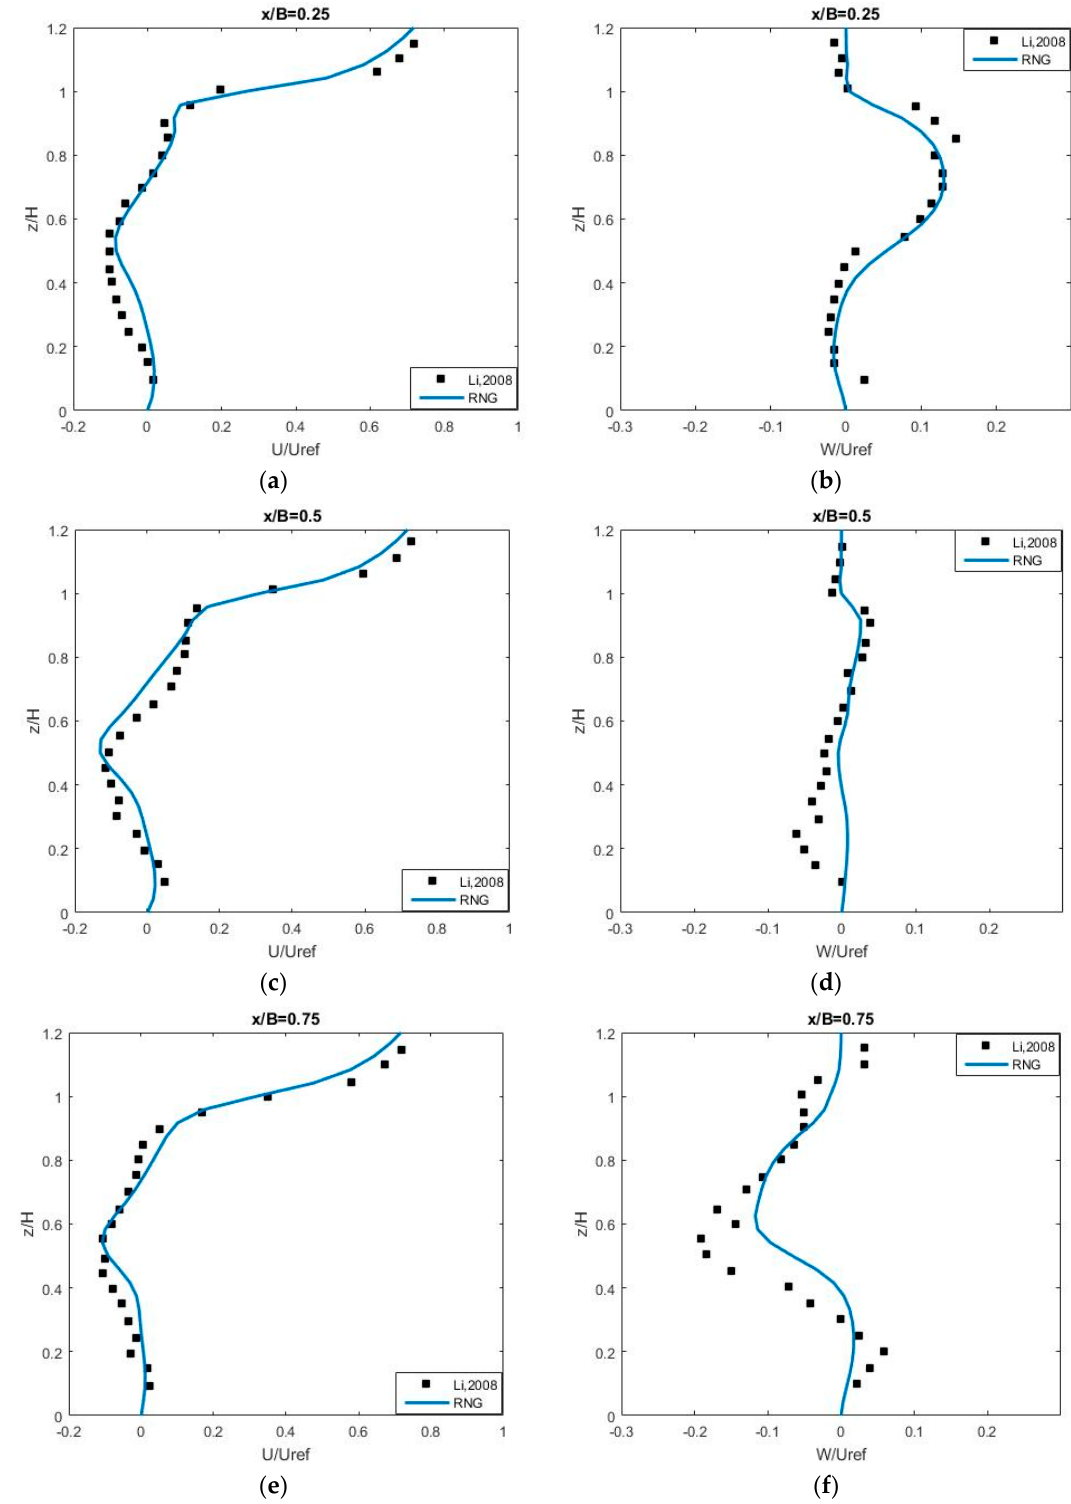
Figure 6. The vertical profile of normalized streamwise ( a , c , e ) and vertical ( b , d , f ) velocities with AR = 2.0.